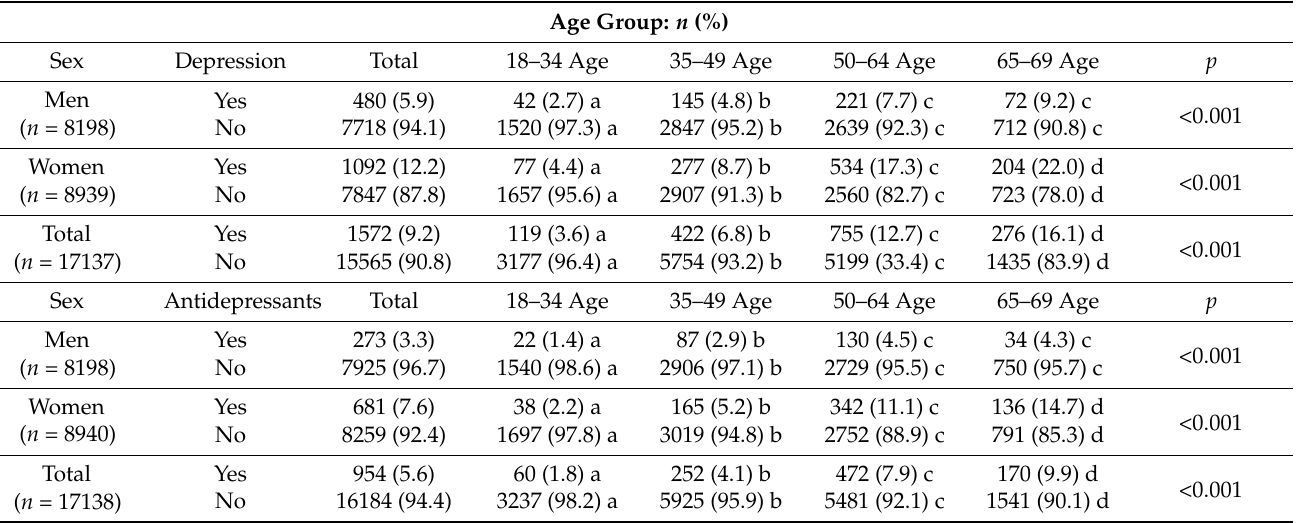
Table 3. Relationship between the prevalence of anxiety and age group in the general Spanish population of the 2017 ENSE aged between 18 and 64 years, and by